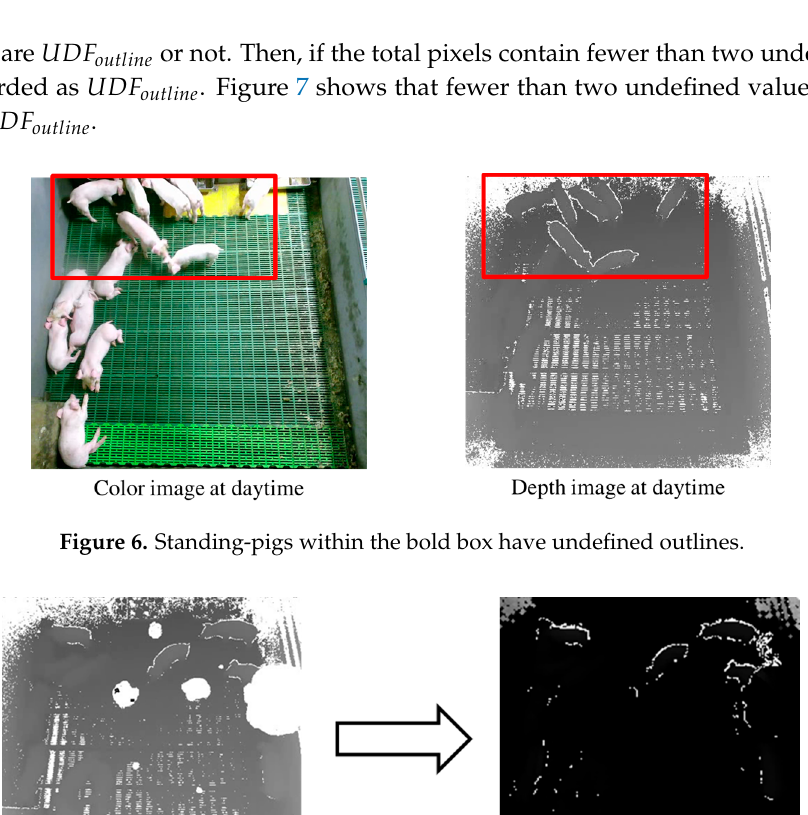
Figure 7. Result of detecting UDF outline around standing-pigs.